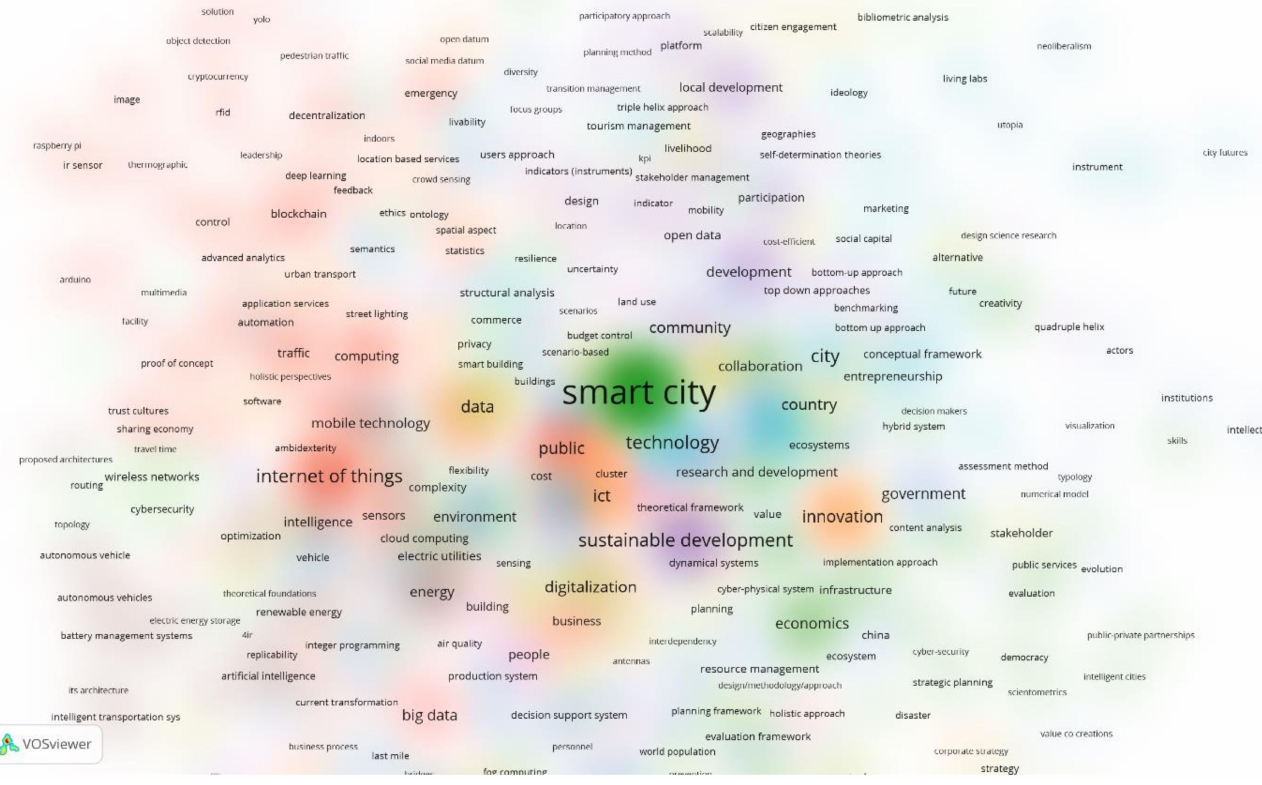
Figure 14. Cluster density